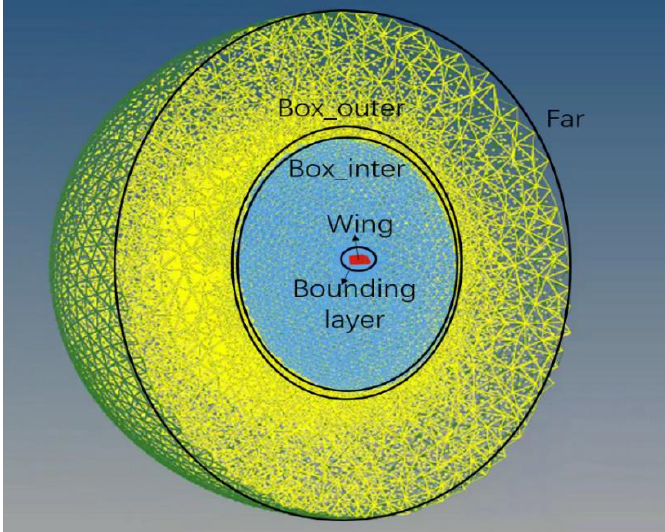
Figure 4. The CFD grid structure and mesh of the fluid field.